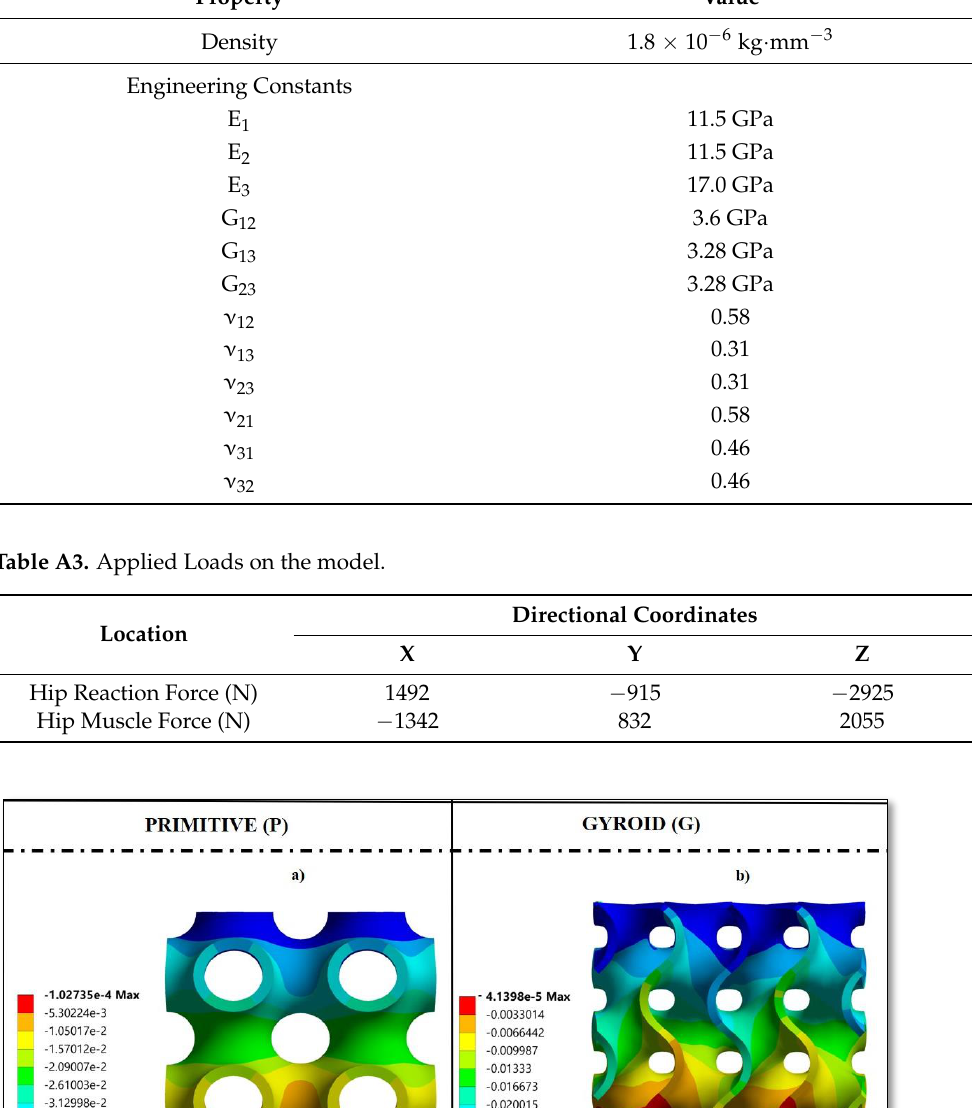
Table A2. Adopted orthotropic material properties for finite element femur construct.